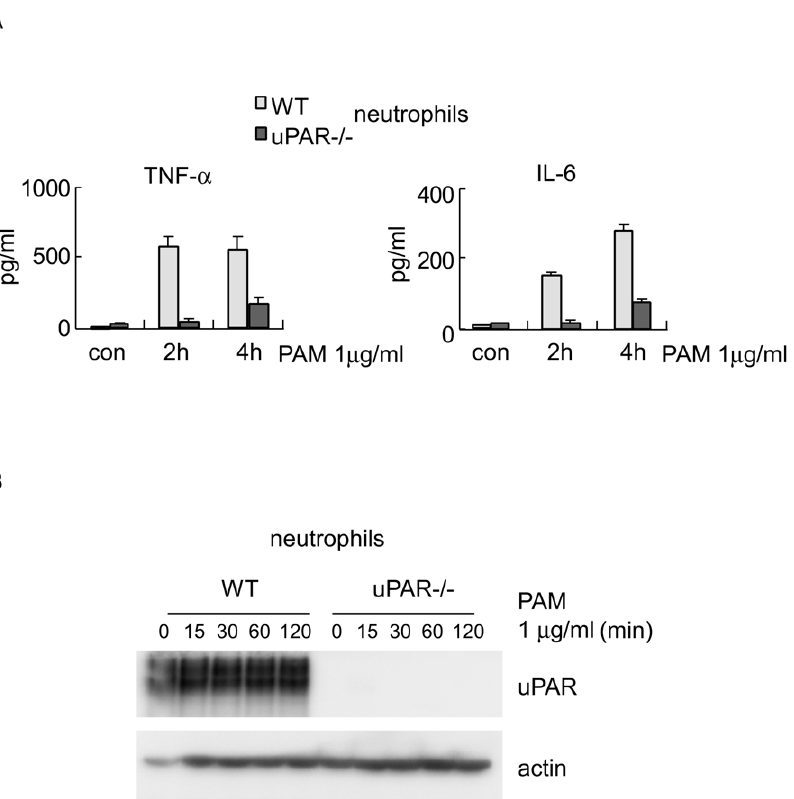
Figure 1. uPAR is required for neutrophil activation upon TLR2 stimulation. (A) 1 6 10 6 WT and uPAR-/- neutrophils were treated with 1 m g/ ml PAM for 0, 2, or 4 hours, and the levels of TNF- a and IL-6 in the supernatants determined. Neutrophils from 3–4 mice were pooled and equally divided into indicated treatment groups. n=3 for each condition; Mean 6 SD. The levels of TNF- a and IL-6 in the supernatants of stimulated uPAR-/- neutrophils were significantly less than those of stimulated WT cells. One representative experiment is shown. Three other independent experiments provided similar results. (B) 4 6 10 6 WT and uPAR-/- neutrophils were treated with 1 m g/ml PAM for 0, 15, 30, 60 or 120 minutes. The cells were collected and cellular extracts prepared. The levels of uPAR were determined by Western blotting. The levels of actin were used as loading controls.